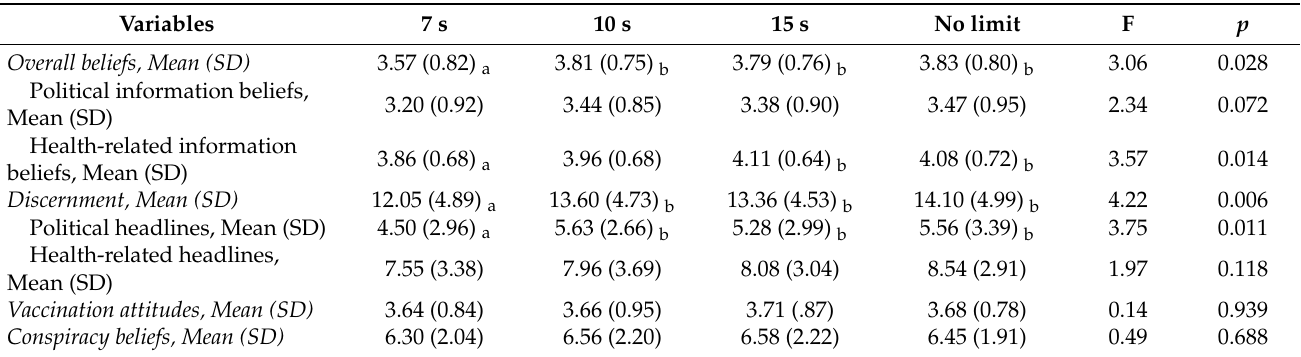
Table 3. Differences between the means and standard deviations of variables used in models between experimental